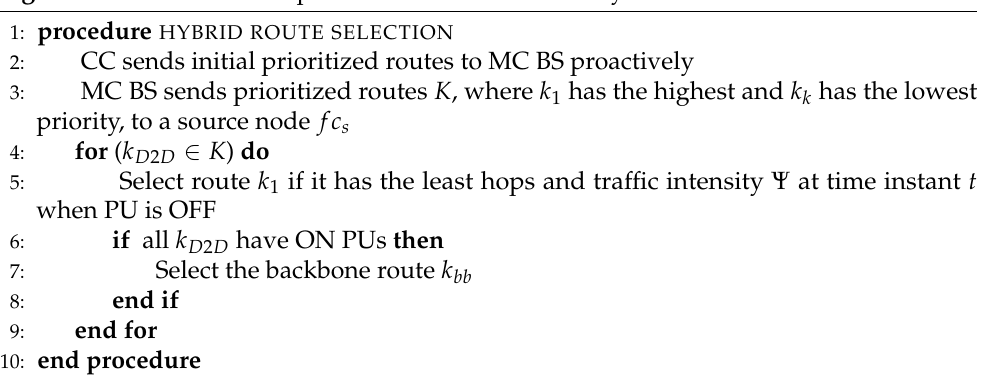
Algorithm 1 General description of the route selection by the source